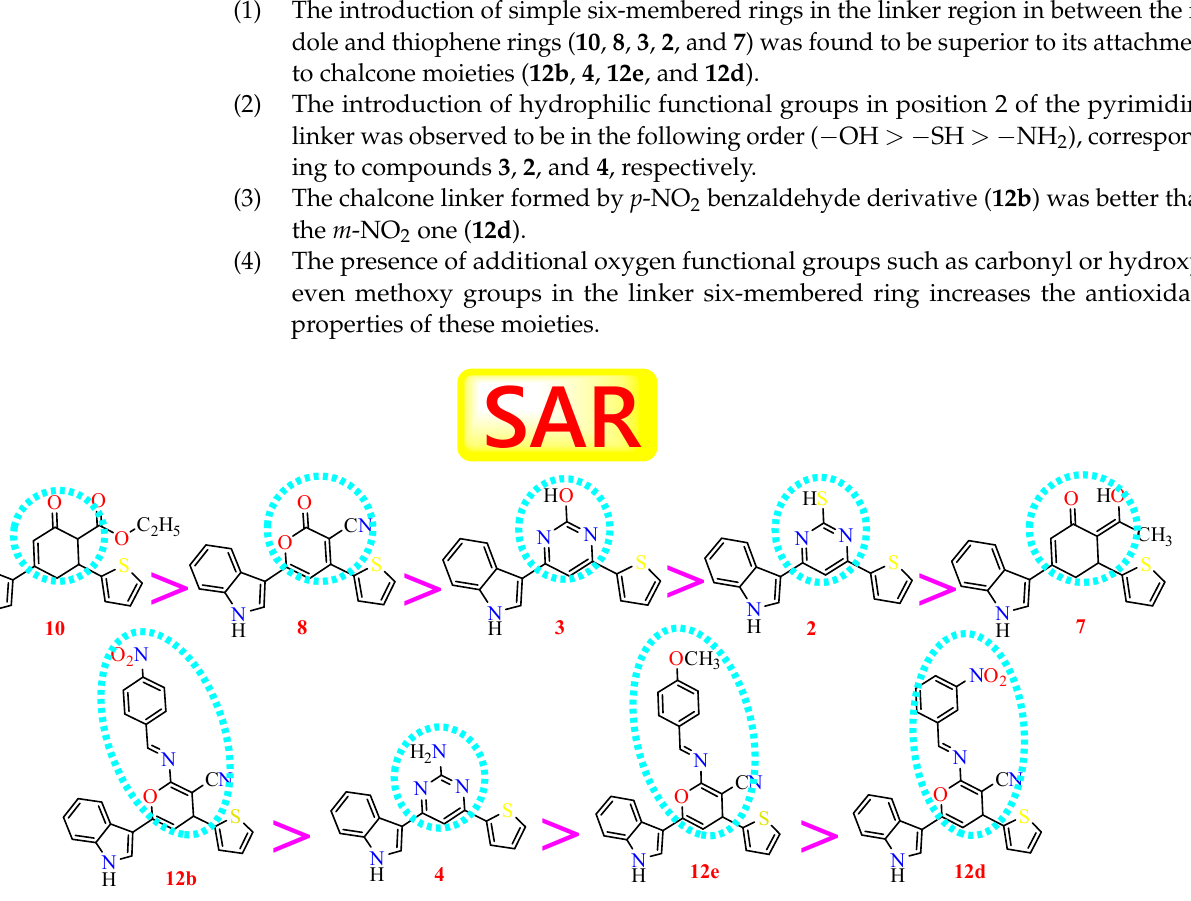
Figure 4. Structure-activity relationship study of the newly designed and synthesized derivatives tested biologically as antioxidants.